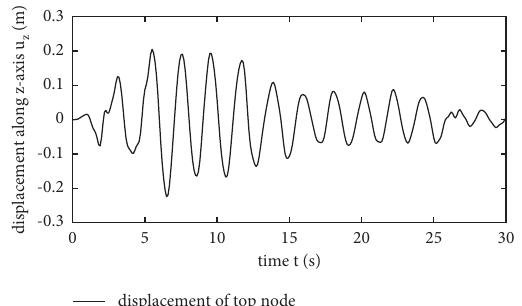
Figure 8: Displacement of top node (o) along the (z)-axis.